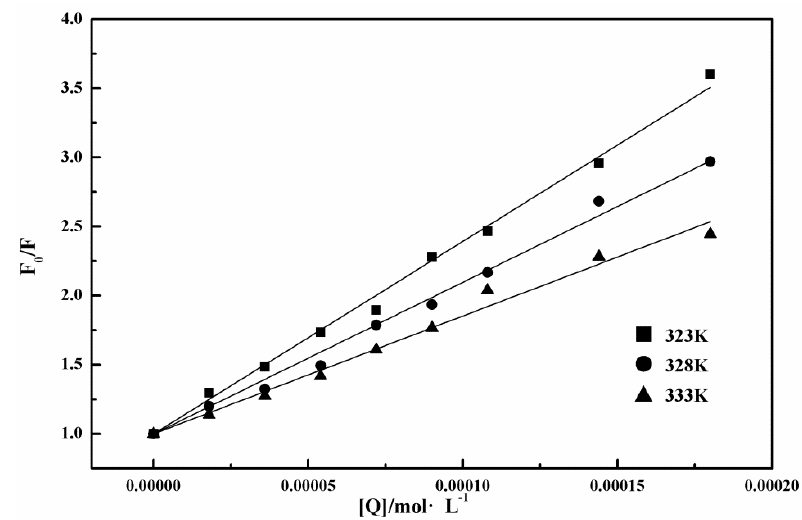
Figure 7. Stern–Volmer plots for lysozyme quenched by tannic acid at 323, 328, and 333 K. Table 1. Stern–Volmer parameters of a lysozyme–tannic acid system at 323, 328, and 333 K.